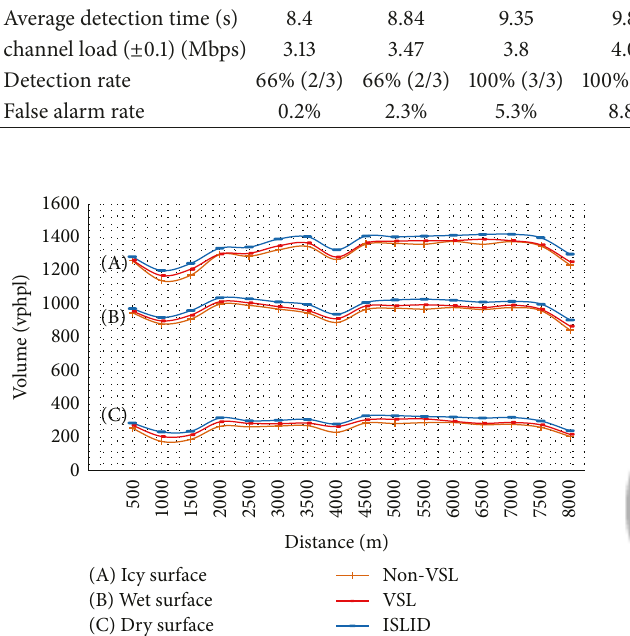
Figure 16: Impacts of Non-VSL, VSL, and IASLD on average volume of vehicles in congestion-free